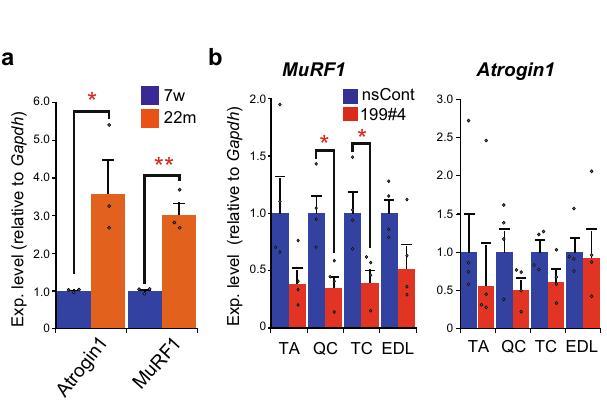
Fig. 6 Suppression of genes related to the muscle atrophy pathway by miR199#4 treatment. a Expression of Atrogin1 and MuRF1 in young and aged muscles. The expression of Atrogin1 and MuRF1 , which are involved in the muscle atrophy pathway, in young (7-week-old: 7w) and aged (22- month-old: 22m) mice was examined by qRT-PCR as in Fig. 1b, and normalized to the data of young mice as 1. Data are shown as mean ± SEM [ n = 3 mice; * p < 0.05, ** p < 0.01 by Student ’ s t test (two-tailed)]. b Suppression of MuRF1 and Atrogin1 by miR199#4 treatment. Total RNA was extracted from the quadriceps (QC), triceps (TC), extensor digitorum longus (EDL), and TA muscles in aged mice intravenously injected with miR199#4 (199#4) or nsCont (the same mice examined in Fig. 5e, f), and the level of MuRF1 and Atrogin1 was examined by qRT-PCR followed by the delta – delta Ct analysis as in Fig. 2a, b. Data are shown as mean ± SEM [ n = 4 treated mice; * p < 0.05 by Student ’ s t test as candidates related to rejuvenation and aging, but the results are controversial 13 . (Table 1 and Fig. 1a). In addition, the expression of muscle